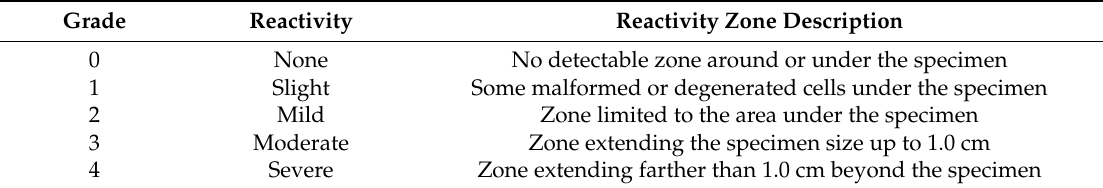
Table 1. International Organization of Standardization (ISO) 10993-5:2009 criteria for reactivity scoring of the agar di ff usion assay